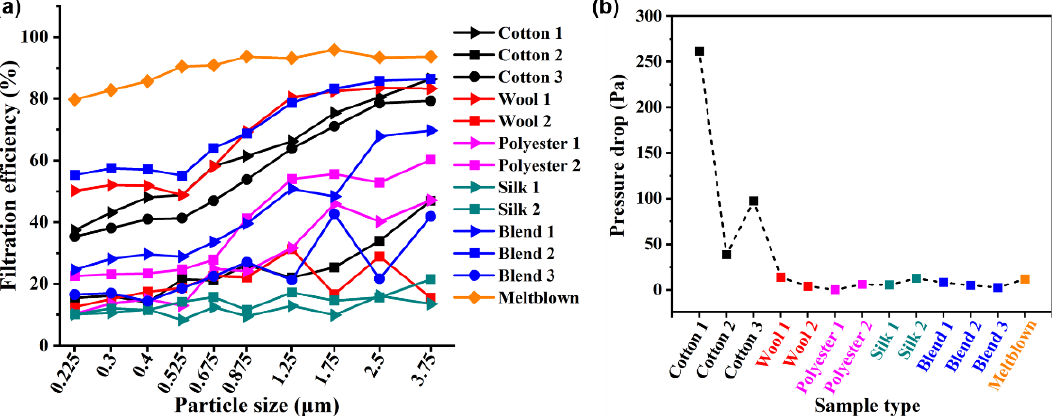
Figure 2. ( a ) The filtration efficiency in the range from 0.225 µ m to 3.75 µ m and ( b ) the pressure drop for the 13 samples. Table 3. Filtration and air permeability performances for single and double layers of different fabrics.